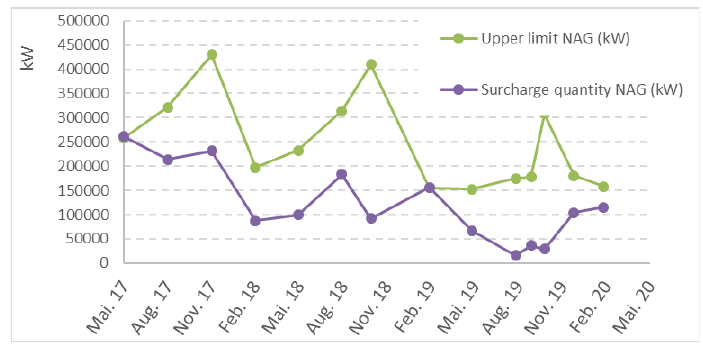
Figure 6. Upper limit and additional amount in the network expansion area in Germany at the bidding dates according to the Renewable Energy Sources Act (EEG) 2017 (in kW) [20], own presentation. Energies 2020 , 13 , x FOR PEER REVIEW